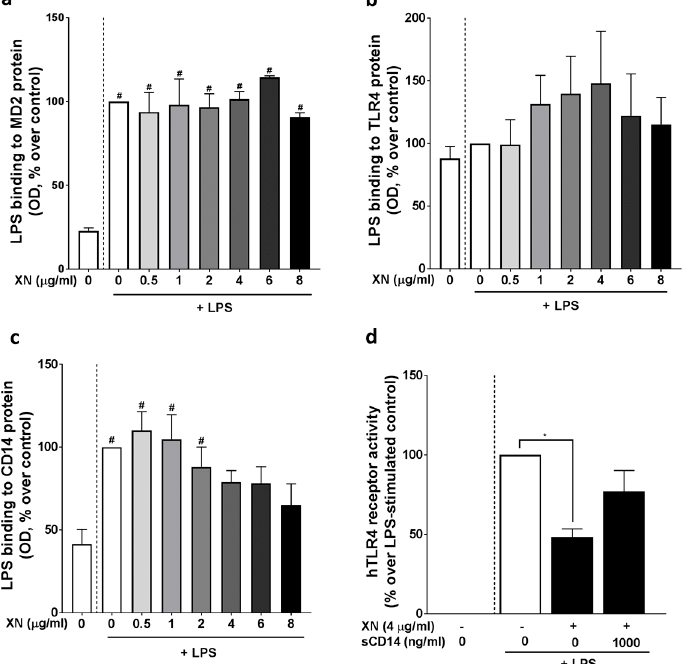
Figure 6. Inhibitory effect of XN on LPS − binding to MD − 2, TLR4 and CD14. Effect of increasing concentrations of XN (0–8 μ g/mL) on LPS − binding to MD − 2 ( a ), TLR4 ( b ) and CD14 ( c ) as well as receptor activity of hTLR4 HEK293 cells co − stimulated with LPS (100 ng/mL), XN (4 μ g/mL) and sCD14 (1000 ng/mL) for 12 h ( d ). LPS, lipopolysaccharide; MD − 2, myeloid differentiation factor 2; sCD14, soluble cluster of differentiation 14; TLR, toll − like receptor; XN, xanthohumol derived through a XN − rich hop extract. Data are expressed as means ± SEM. # = p < 0.05 compared to unstimulated control (0 ng/mL LPS, 0 μ g/mL XN). * = p < 0.05 compared to LPS − stimulated cells.